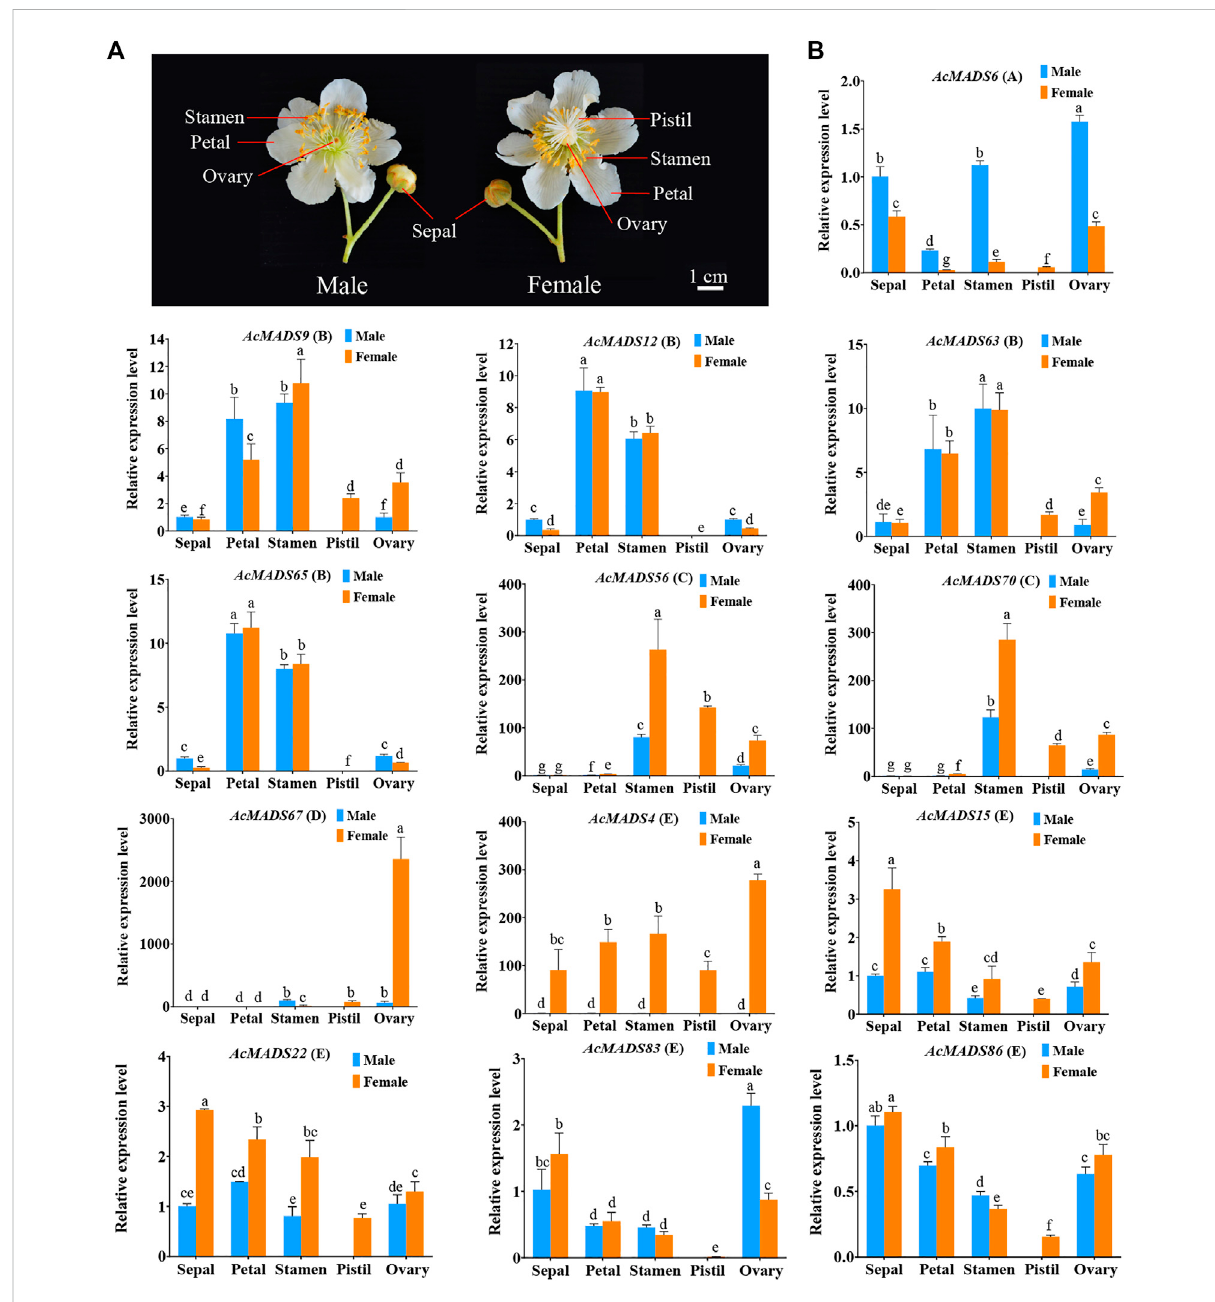
FIGURE 8 Expression patterns of fl oral organs development ABCDE model-related AcMADS-box genes in male and female fl owers of kiwifruit. (A) Structure of male and female fl owers of kiwifruit. The sepal, petal, stamen, and degenerated ovary of male fl owers, and sepal, petal, aborted stamen, pistil and ovary of female fl owers. (B) . The qRT-PCR analysis of fl oral organ ABCDE model-related AcMADS-box genes in kiwifruit male and female fl owers. AcMADS6 belongs to type A; AcMADS9, AcMADS12, AcMADS63 , and AcMADS65 belong to type B; AcMADS56 and AcMADS70 belong totypeC; AcMADS67 belongto typeD; AcMADS4, AcMADS15,AcMADS22,AcMADS83 ,and AcMADS86 belongto typeE.The datawereanalyzedfor signi fi cance of differences by one-way ANOVA test ( p < 0.05). Bars with the same small letters are not signi fi cantly different, and bars that do not share the same small letters are signi fi cantly different from each